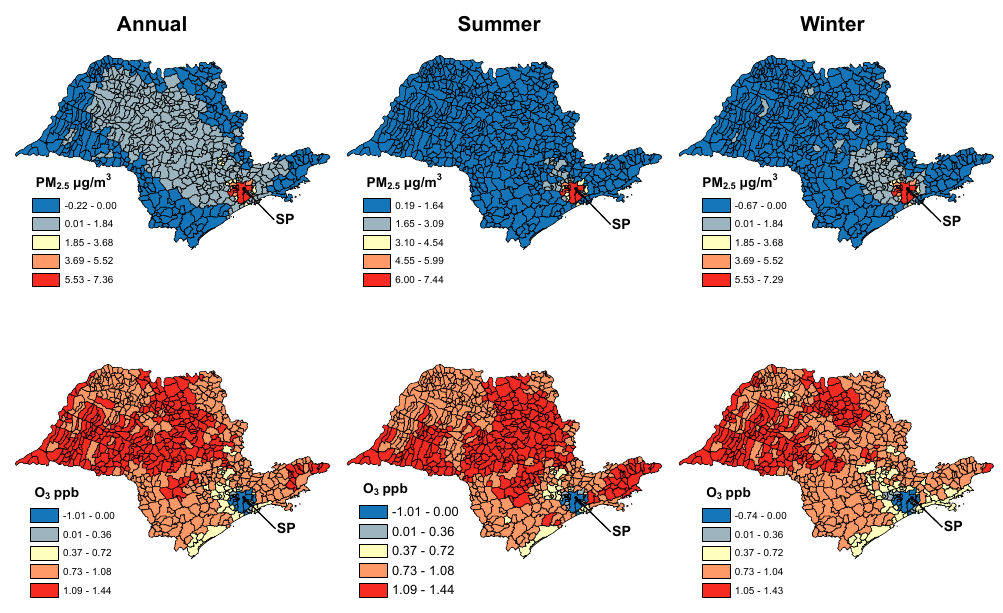
Figure 3. Difference in the concentration of fine particulate matter (PM 2.5 ) (average) and ozone (O 3 ) (average of 1 h maximums) in each of the 645 municipalities of São Paulo State. Positive values indicate higher concentrations in the Ethanol Expansion scenario.